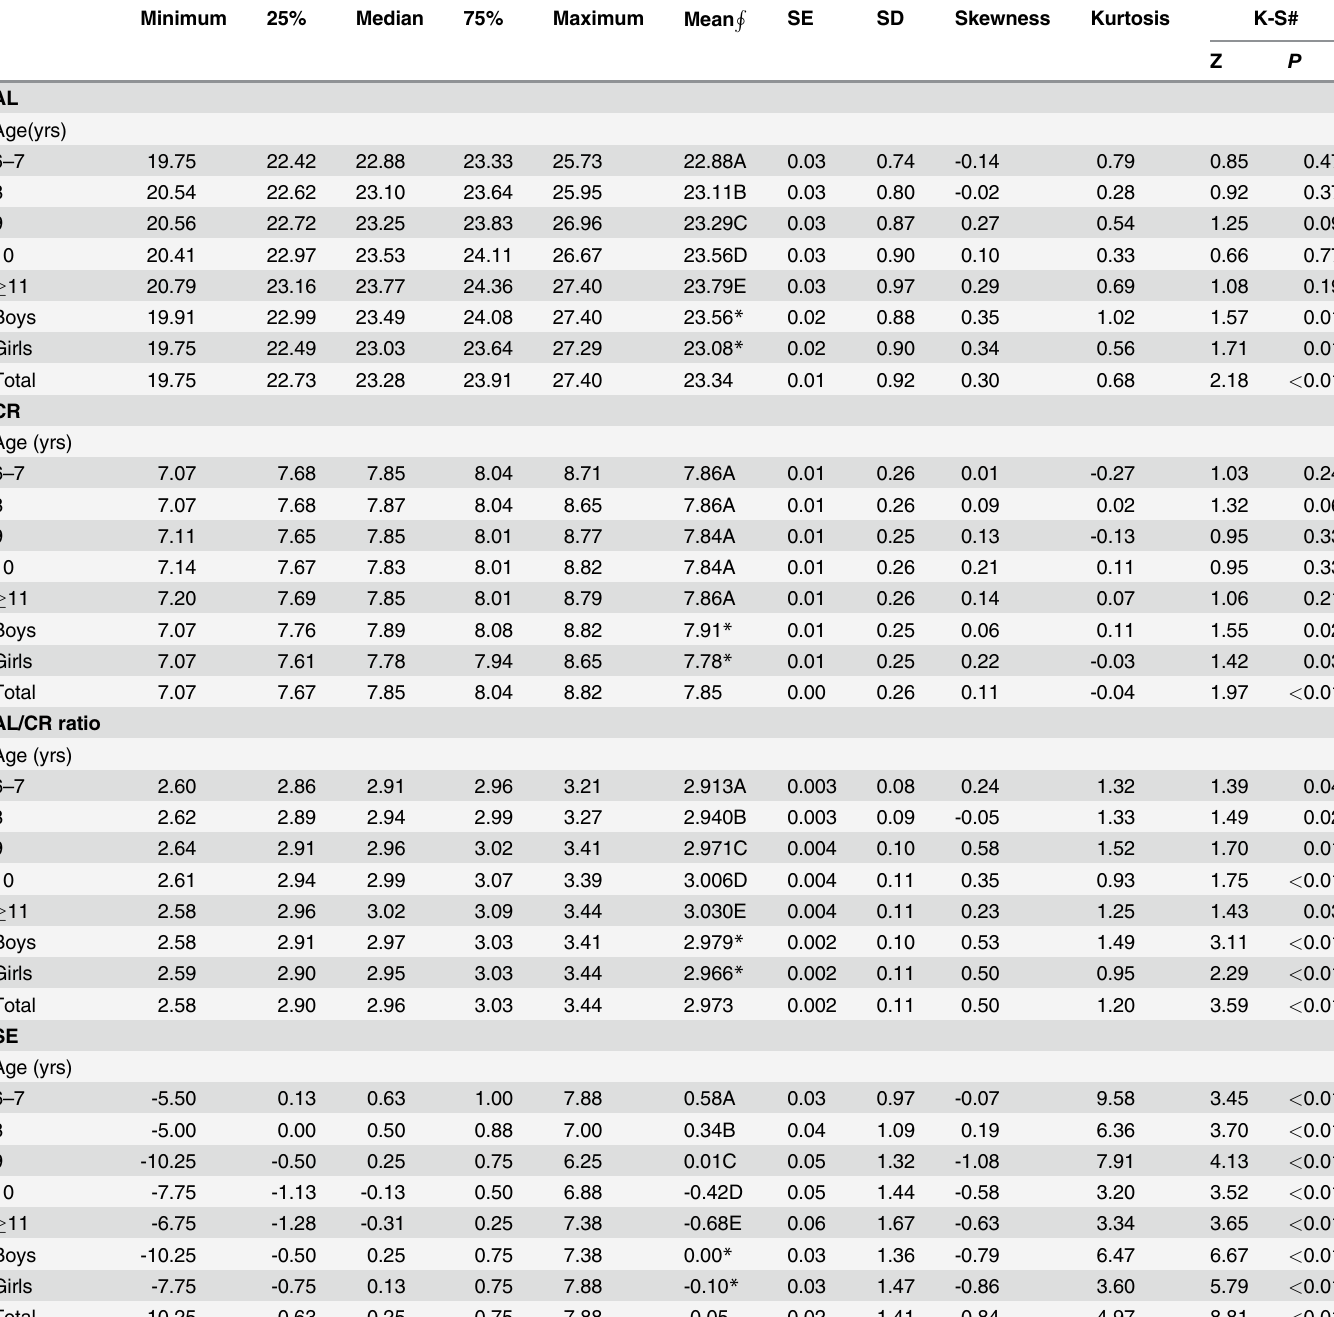
Table 2. Measures of spread for refraction (SE) and ocular biometric parameters in the right eyes of children by age and